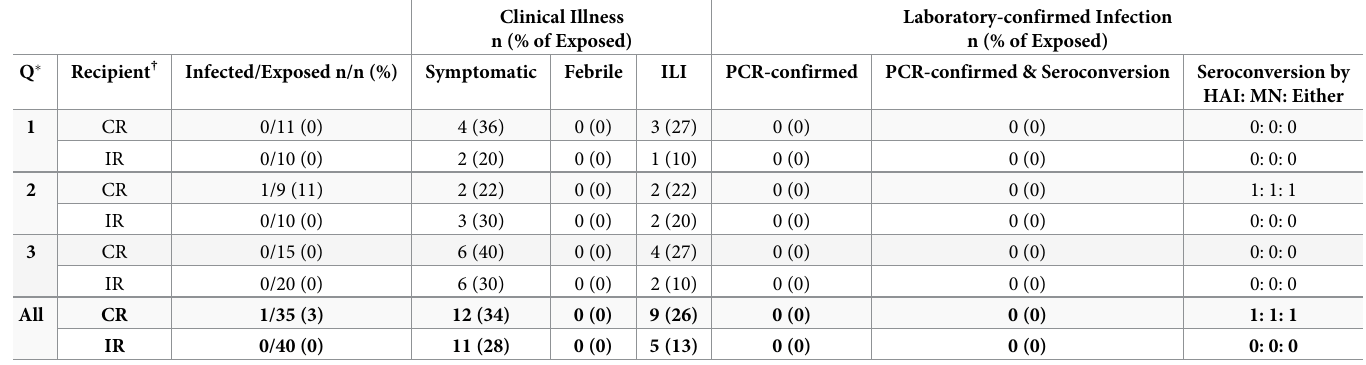
Table 3. Recipient